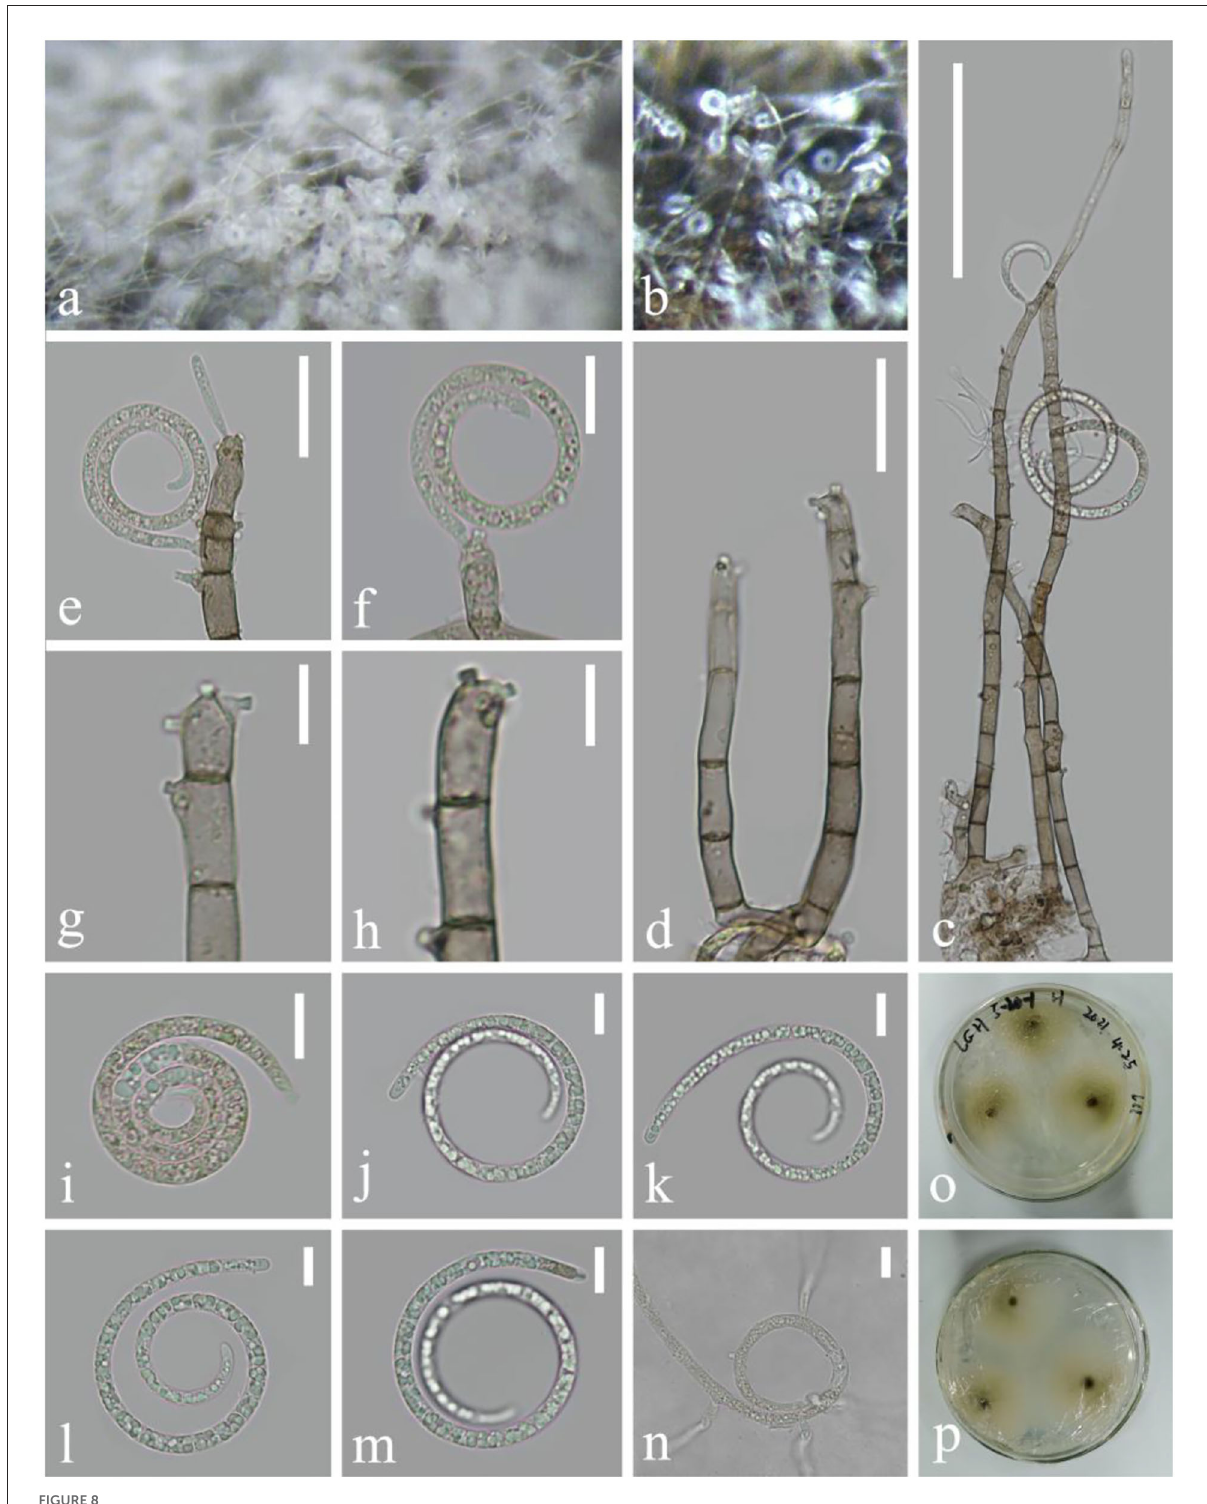
FIGURE8 Tubeufia cylindrothecia (KUN-HKAS 124602). (a,b) Colony on decaying wood. (c) Conidiophores with attached conidia. (d) Conidiophores. (e–h) Conidiogenous cells. (i–m) Conidia. (n) Germinating conidium. (o,p) Colony on CMA observed from above and below. Scale bars: (c) 70 µ m, (d,e) 20 µ m, and (f–n) 10 µ